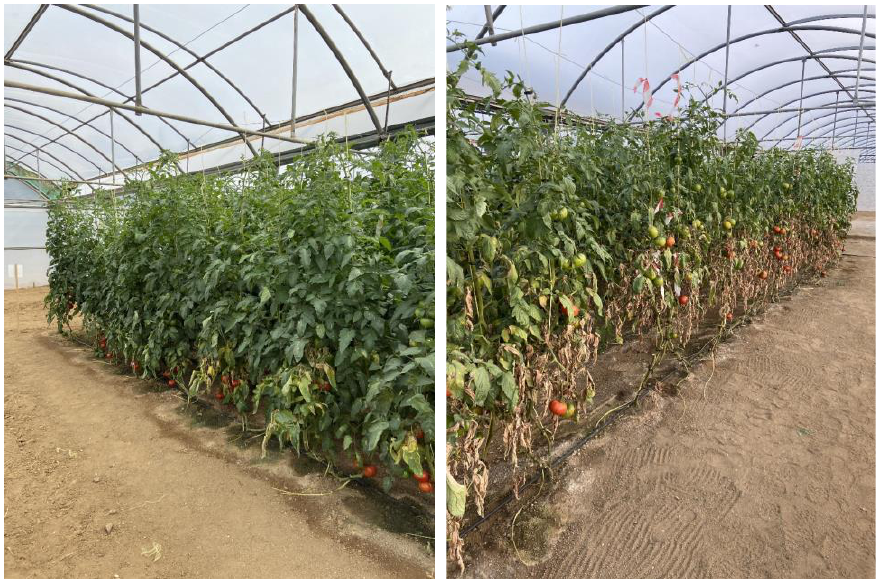
Figure 6. Appearance of plants in the biological ( left ) and control plot ( right ) at the end of the autumn crop.